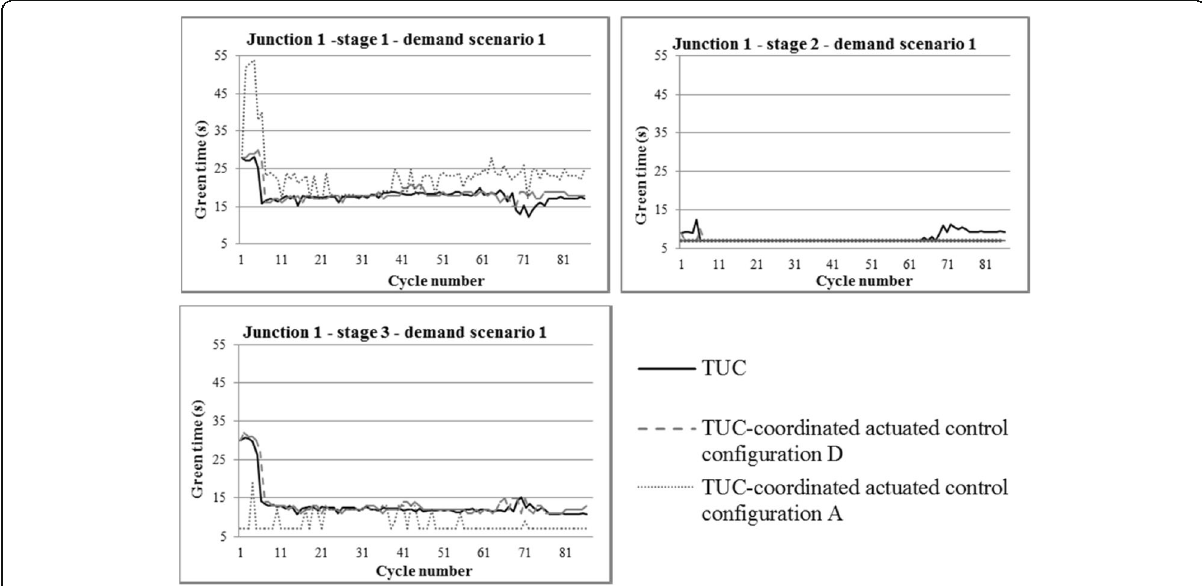
Fig. 3 Green times of TUC vs TUC-coordinated actuated control configuration cases A and D; stage 1 is the main TUC stage at junction